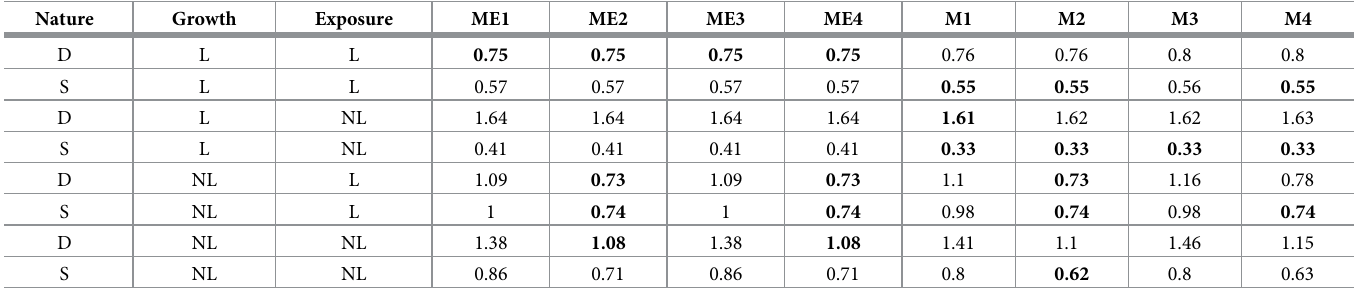
Table 5. The mean absolute velocity error (MAVE) averaged over 1000 simulated data sets for a set of eight models under 8 different data conditions specified by the nature of the relationship, form of the growth patterns, and the form of the effect modification from the exposure. Smallest average MAVE for each data condi- tion is bold.